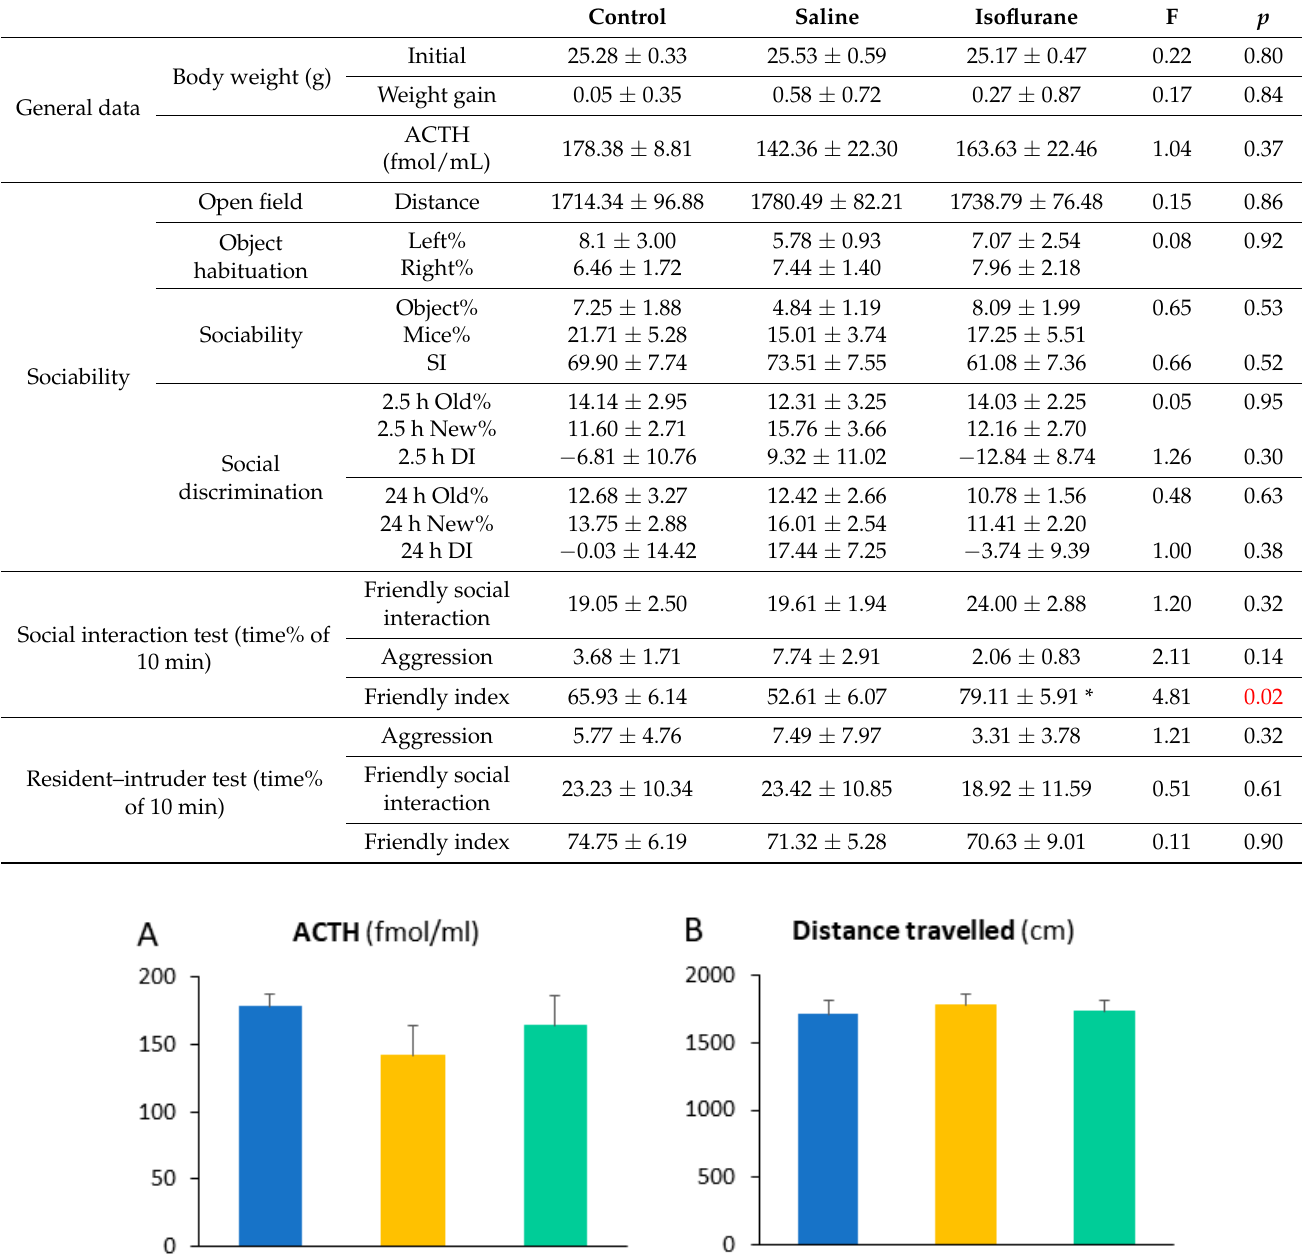
Table 1. Summary of the results. Data were analysed by one-way ANOVA (degree of freedom (2, 28)). For object habituation and sociability, the effect of treatment is given based upon repeated measure ANOVA analysis. The preference for stimulus mice during sociability was highly significant (F (1,28) = 17.24; p < 0.01) without any influence of the treatment. * p < 0.05 vs. saline-treated; the significant difference is highlighted by red.